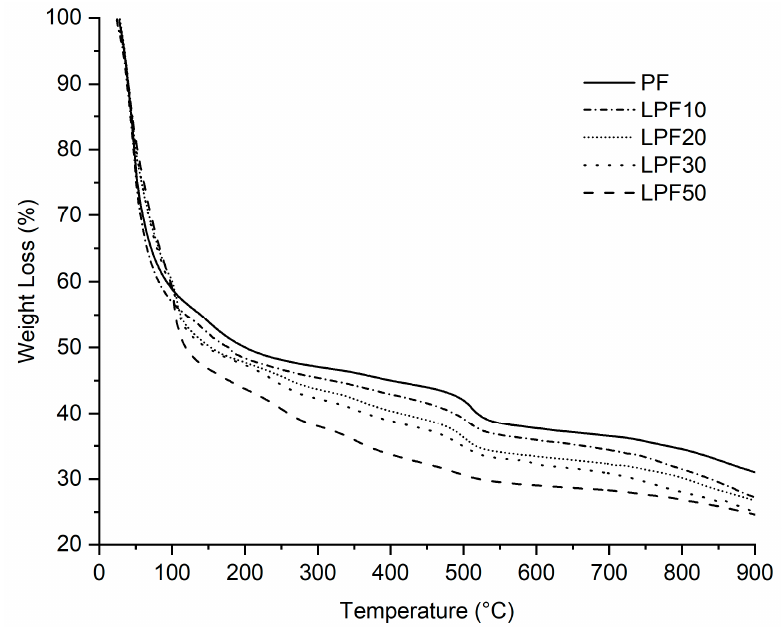
Figure 5. Thermogram results for the different resins.